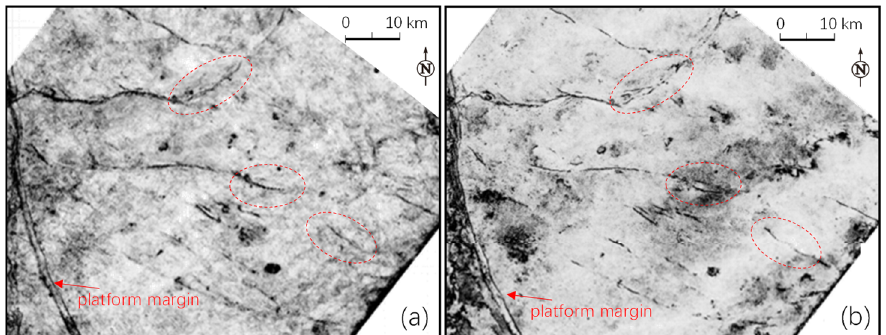
Figure 3. Seismic coherence attribute at top of the Ediacaran by ( a ) prestack time migration and ( b ) prestack depth migration processes in Anyue Gasfield (the red circles indicating the prestack depth migration process is better in small strike ‐ slip fault image).